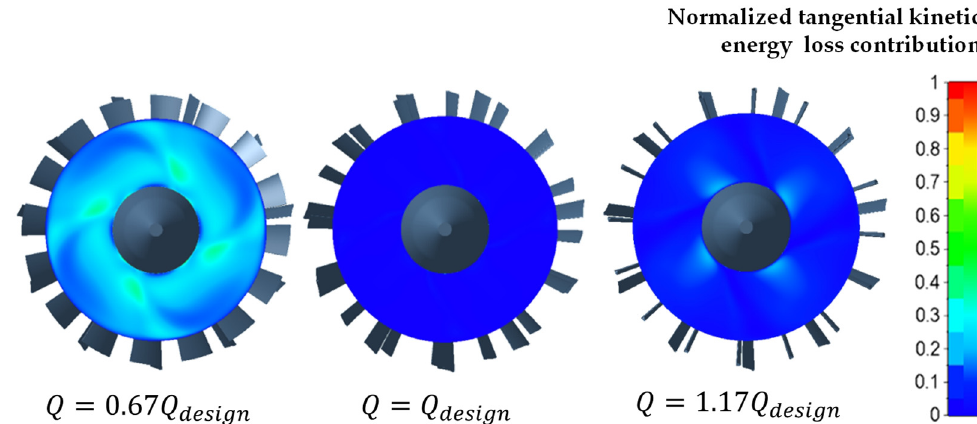
Figure 17. Normalized tangential kinetic loss contribution at a design rotational speed for three dif-